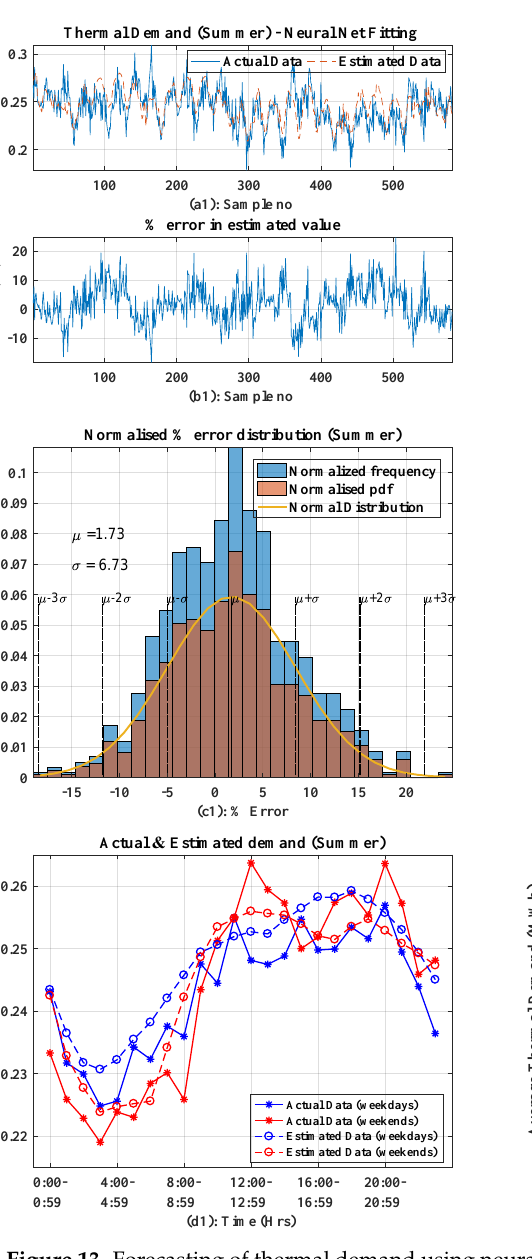
Figure 13. Forecasting of thermal demand using neural net fitting tool for summer and winter. Row ( a ): actual data and estimated data. Row ( b ): % error associated with estimation of thermal demand. Row ( c ): histogram of %error and its normal distribution. Row ( d ): Analysis of average thermal demand (actual and estimated) in hourly basis for different weekdays and